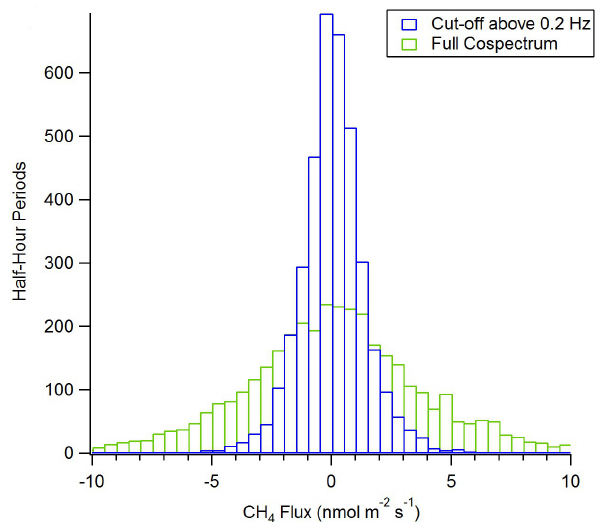
Fig. 2. Histogram of the covariance the entire cospectrum (green) and the contribution above the frequency cutoff of 0.2Hz (blue) for CH 4 flux calculated from the covariance of a stable sample of cali- bration gas and the ambient observations of vertical wind from the sonic